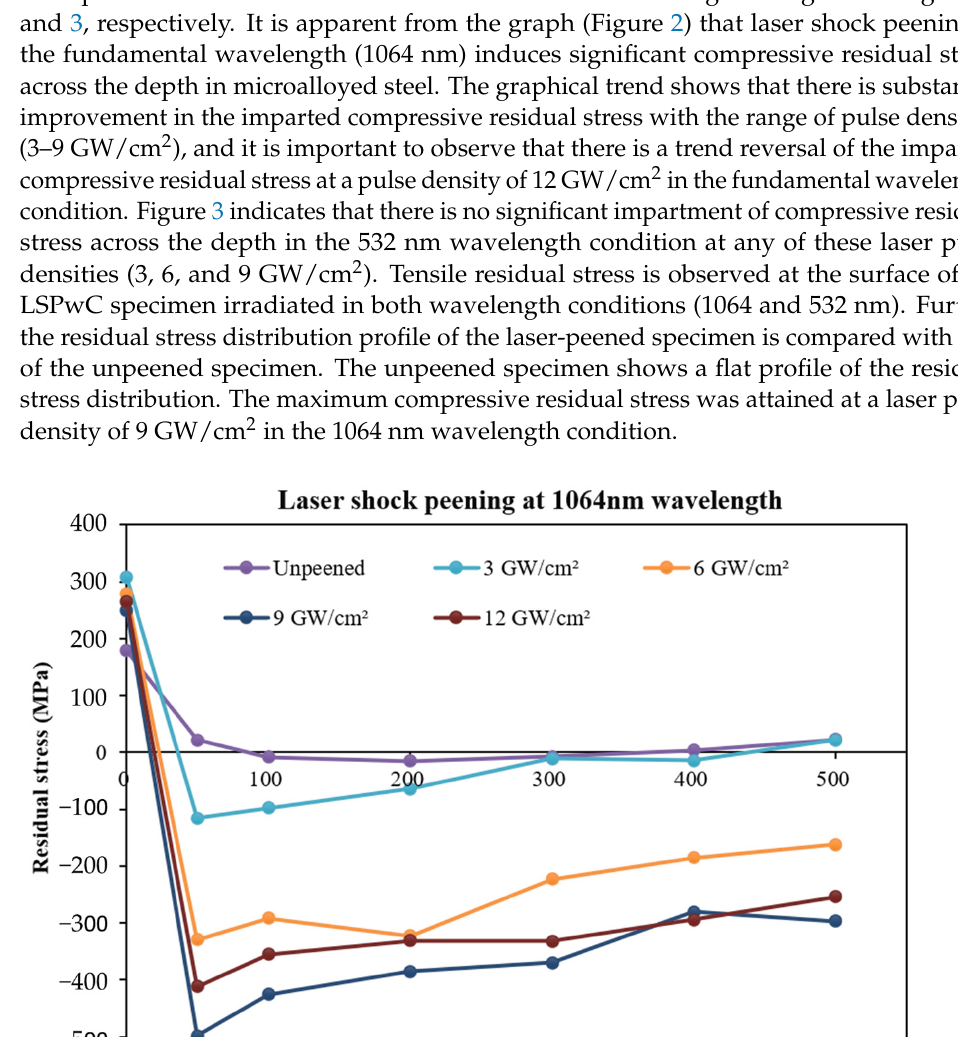
Figure 3. Residual stress distribution profile of LSPwC specimen at 532nm. 3.2. Microstructural Characterization of LSPwC Sample